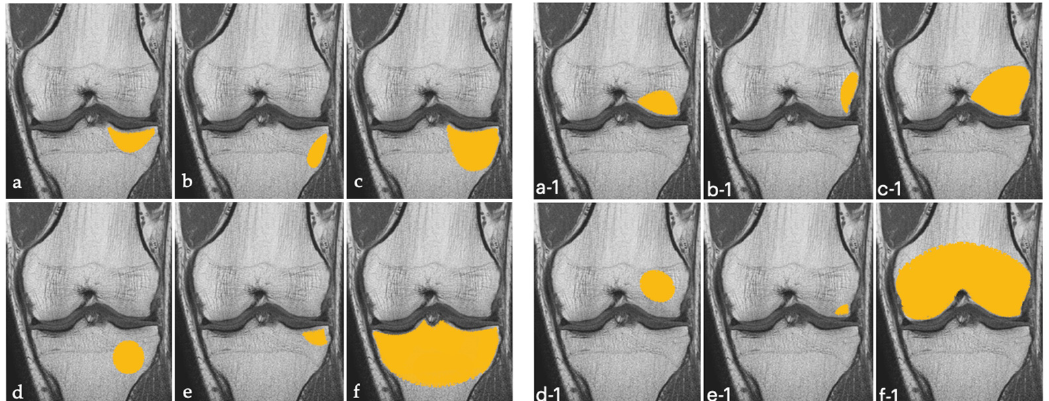
Figure 2. Schematic illustration of tibial (on the left ( a – f )) and femoral (on the right ( a-1 – f-1 )) primary bone marrow edema of the knee, in according to Compagnoni’s classification [18].